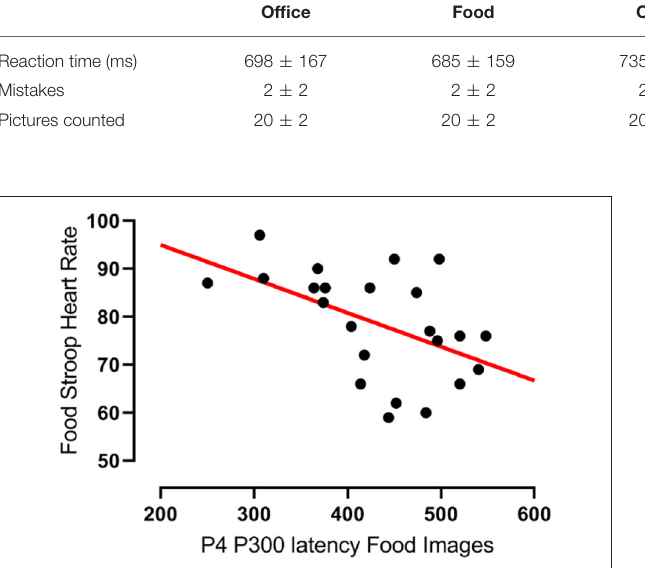
FIGURE 2 | Correlation between the latency of participants’ P300 components evoked by food cues at the right parietal (P 4 ) electrode and their heart rates during the Food Stroop task. r = − 0.51, p < 0.02.